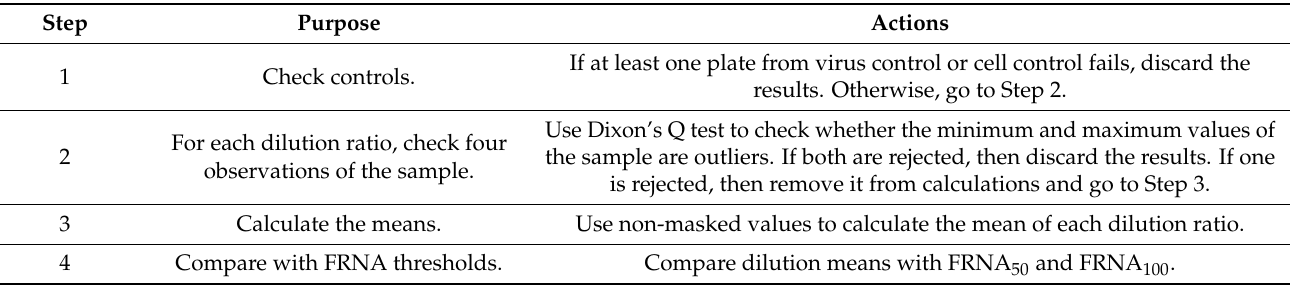
Table 5. Algorithm of handling sample dilution